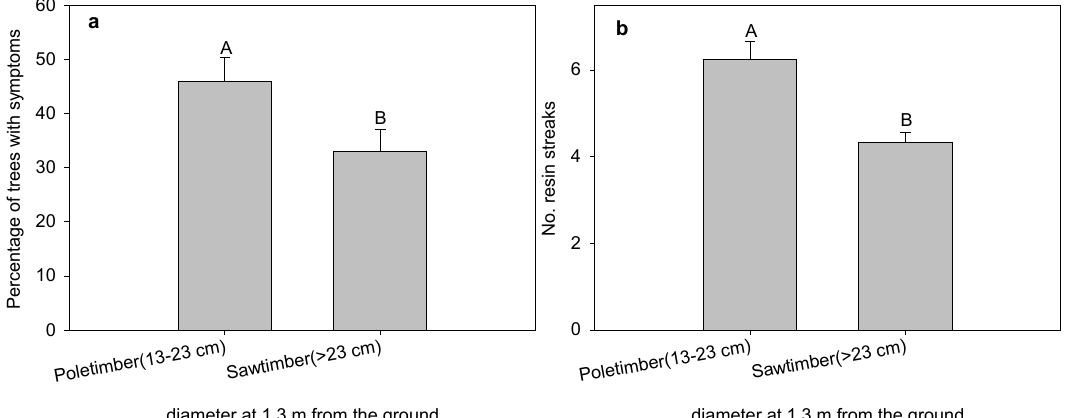
Figure 5. ( a ) Incidence; ( b ) and severity of Caliciopsis canker symptoms in relation to size class. Bars represent means and standard errors. Values with the same letter are not statistically different (α = 0.05) .